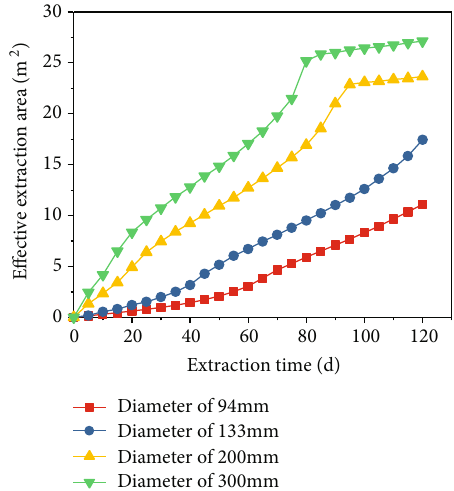
Figure 12: Variation of e ff ective extraction area with di ff erent diameter